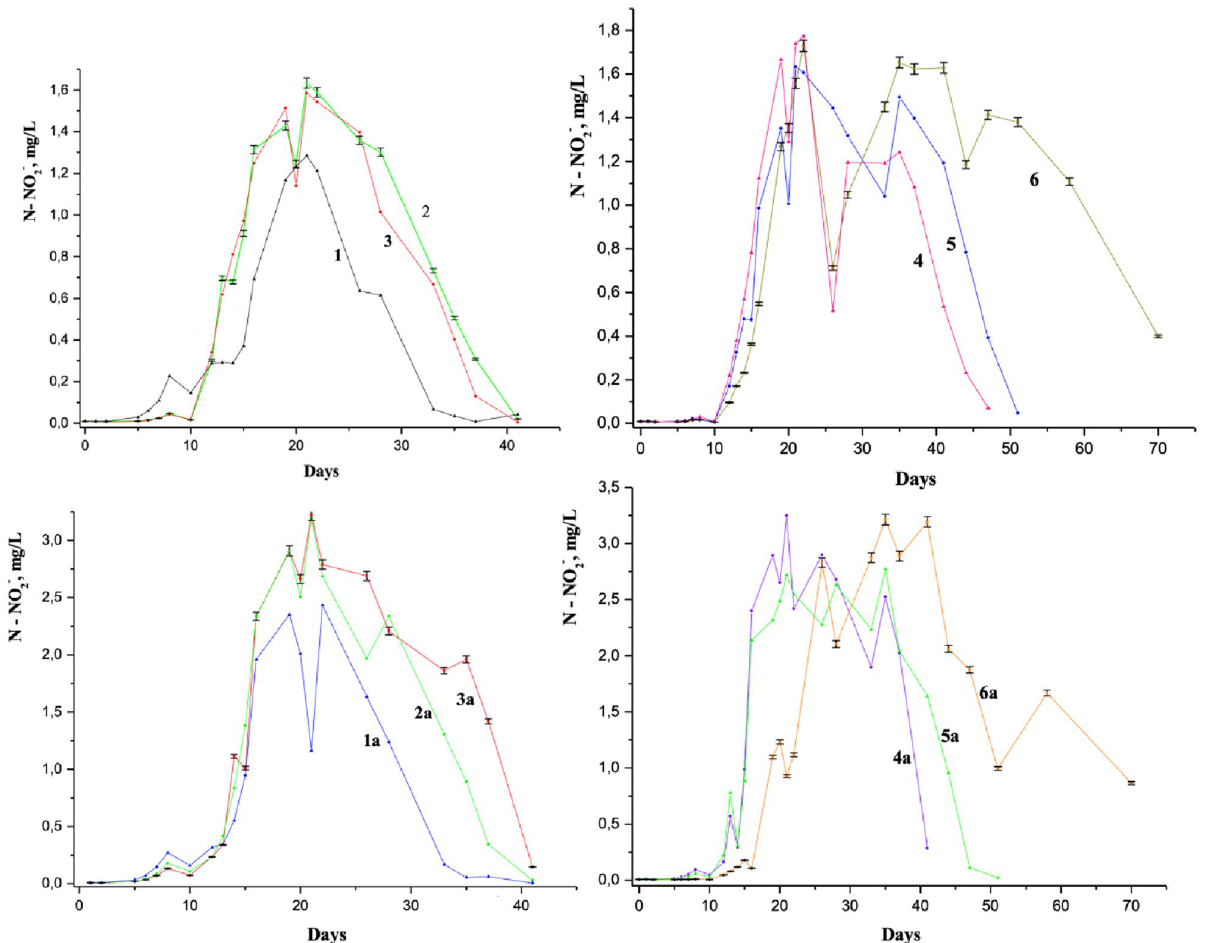
Figure 4. Dynamics of the nitrite ions concentration in the Nistru River water (Vadul-lui-Voda section), containing: 3 mg/L NH 4 + (plots from above) (1—the reference sample, 2—with 0.025 mg/L 1-NA, 3—with 0.05 mg/L 1-NA, 4—with 0.1 mg/L 1-NA, 5—with 0.25 mg/L 1-NA, 6—with 0. 5 mg/L 1-NA) and 6 mg/L NH 4 + (plots from the bottom) (1a—the reference sample, 2a—with 0.025 mg/L 1-NA, 3a—with 0.05 mg/L 1-NA, 4a— with 0.1 mg/L 1-NA, 5a—with 0.25 mg/L 1-NA, 6a—with 0. 5 mg/L of 1-naphtylamine)